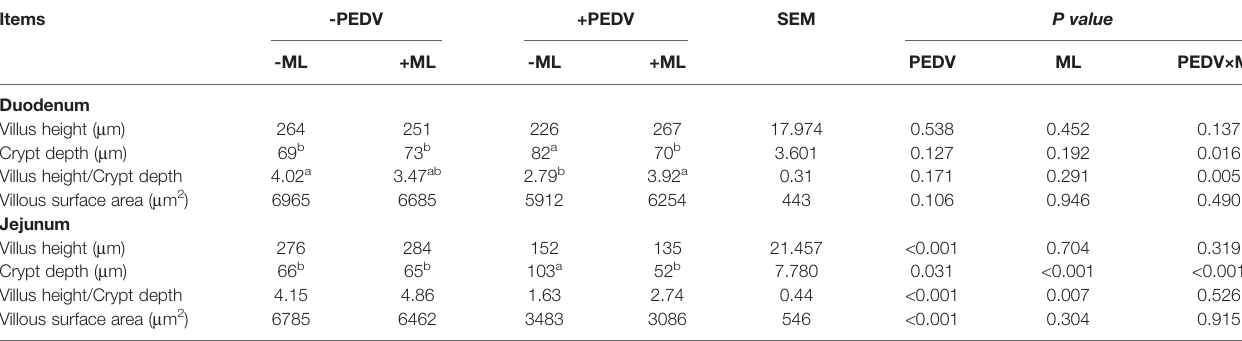
TABLE 2 | Effects of ML administration on intestinal morphology in PEDV-infected piglets.